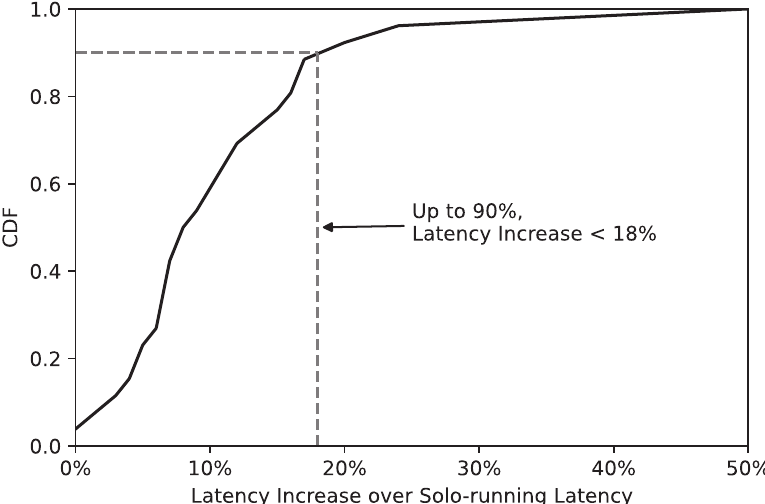
Figure 2. Cumulative distribution of latency increase relative to solo-running latency when bi-instance inference executes on a single GPU. Among all ML-instance co-location combination experiments, e.g., up to 90-percent of bi-instance execution show less than 18% latency increase. Models: ResNet50, Inception-v3, SSD-ResNet50, Transformer. Batch size: 2, 4, 8, 16. In total: 160 combinations, including identical ML-instance co-location combinations and different ML instance co-location